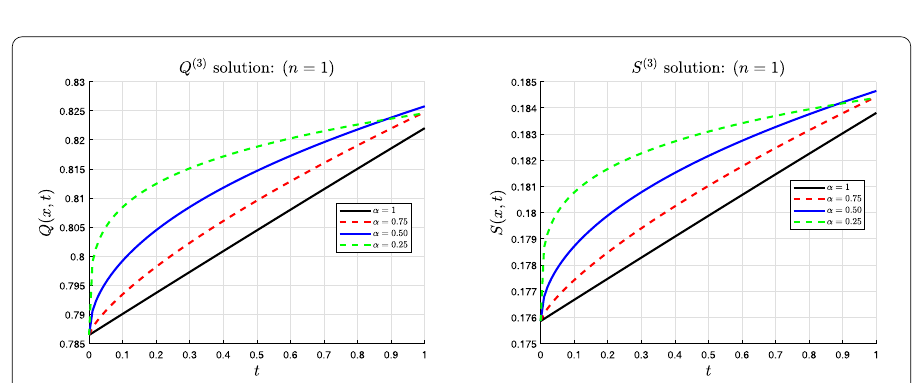
Figure 16 Nature of q-HATM solution with different α when (cid:2) = –1, k = r = 0.1, λ = 1.5, and x = 10 for Example 4.2